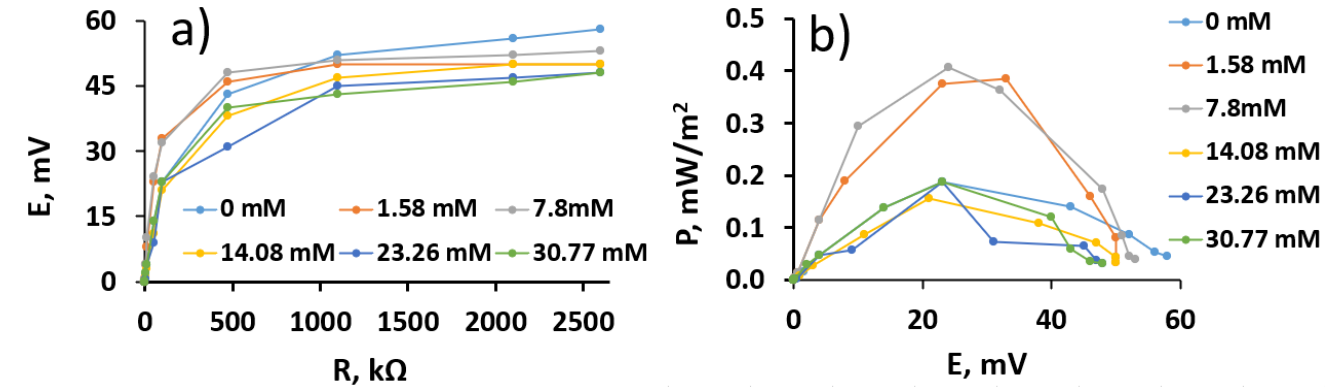
Figure 7. ( a ) Potential dependence on applied load; ( b ) calculated power density dependence on the generated potential in a single-compartment-based Microbial fuel cell (MFC), which consisted of an MD- and yeast-modified anode and a bare graphite cathode immersed in the phosphate–acetate buffer solution containing 23 mM of potassium ferricyanide and variable concentrations of glucose: 0 mM, 1.58 mM, 7.8 mM, 14.08 mM, 23.26 mM, and 30.77 mM.